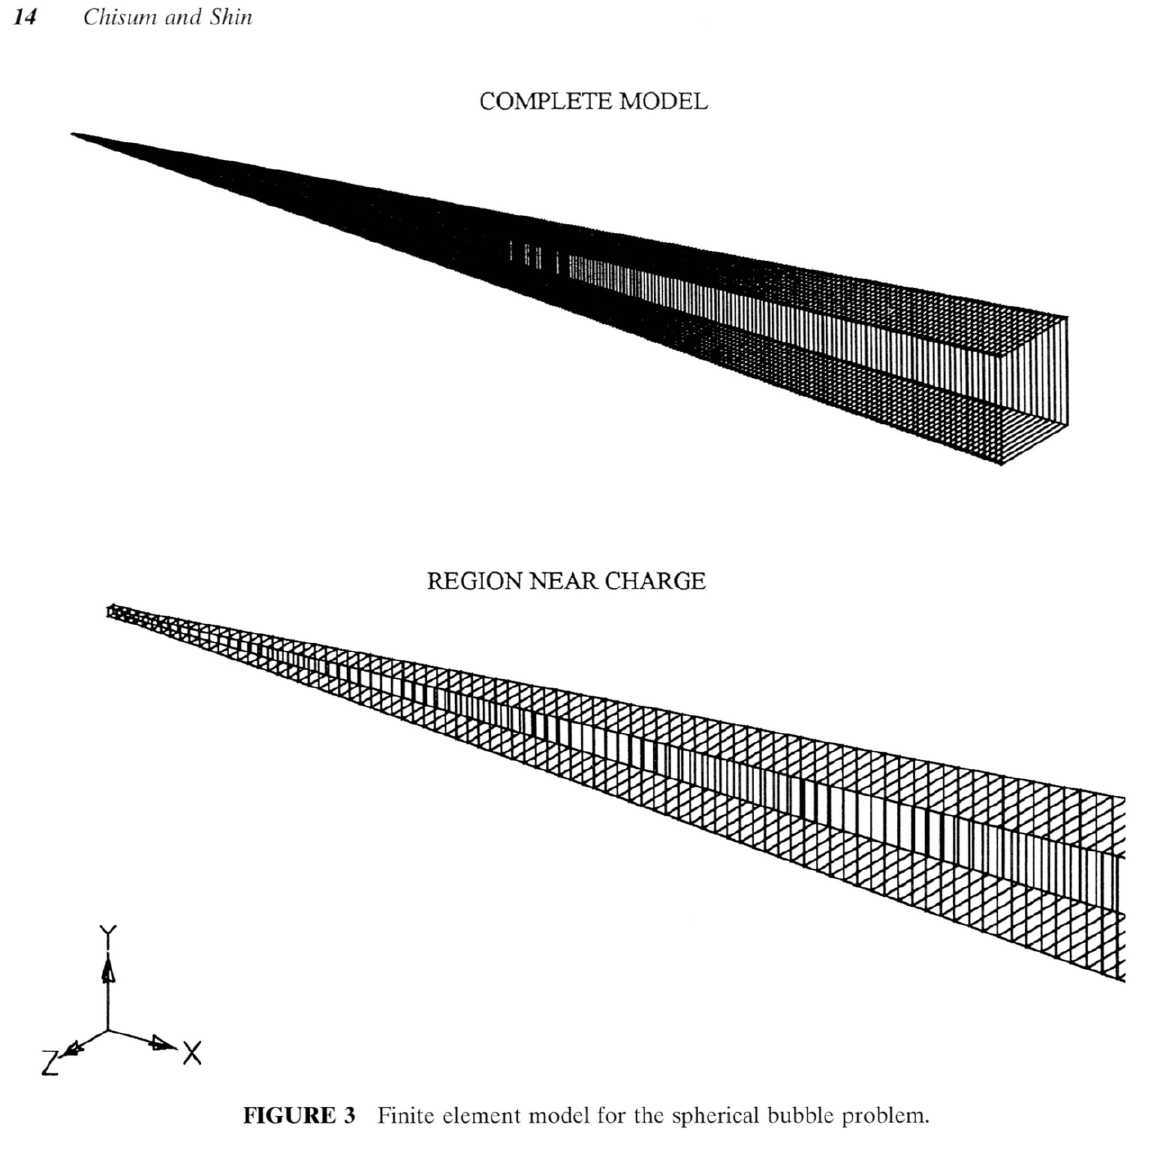
FIGURE 3 Finite element model for the spherical bubble